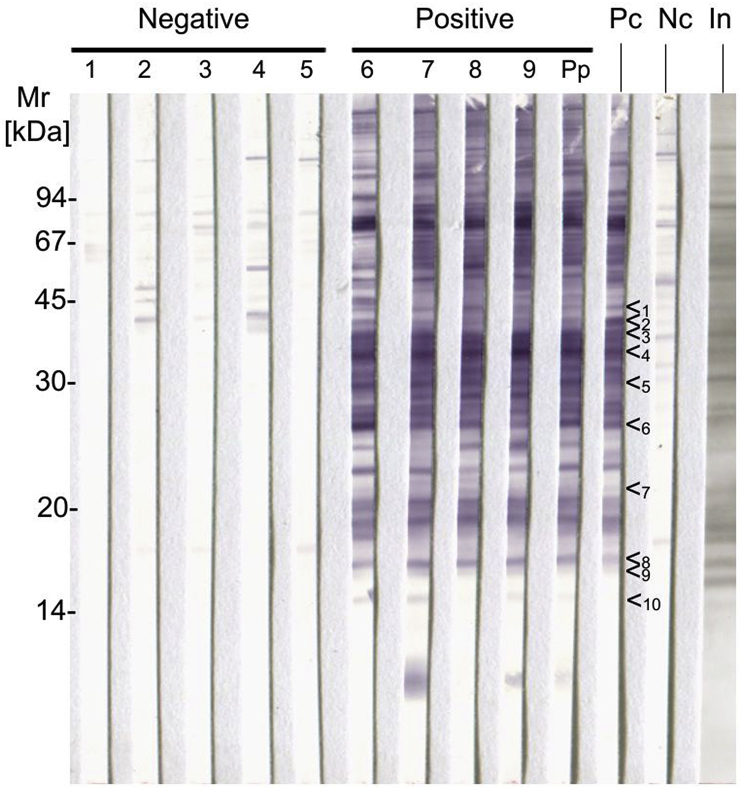
Reactivity of B. tarandi-positive caribou sera with B. besnoiti Bb1Evora03 antigen. Patterns resemble the picture obtained with bovine besnoitiosis sera. Sera from caribou without (Negative, sera 1–5) or with clinical signs of besnoitiosis (Positive, sera 6–9, including the pool of these sera Pp) were tested. A serum from a Besnoitia besnoiti-infected cattle was used as a positive control (Pc) and a B. besnoiti-negative serum as a negative control (Nc). On the right side, an India ink staining (In) of the antigen is displayed. Close to the strip that had been probed with the B. besnoiti positive bovine control serum, the locations of 10 bands are marked (<1-10), which have previously been used to identify specific reactions against B. besnoiti (Schares et al., 2010).